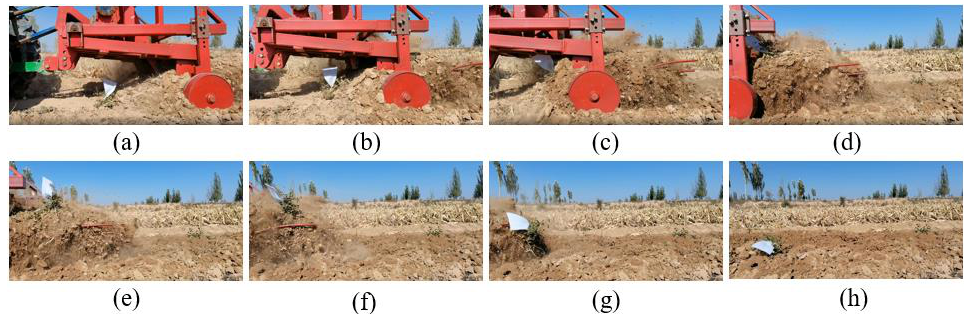
Figure 16. The field test working process and spatial location variations of the maker, Subgraphs ( a – h ) show the order of the marker’s position changes during the liquorice harvesting.